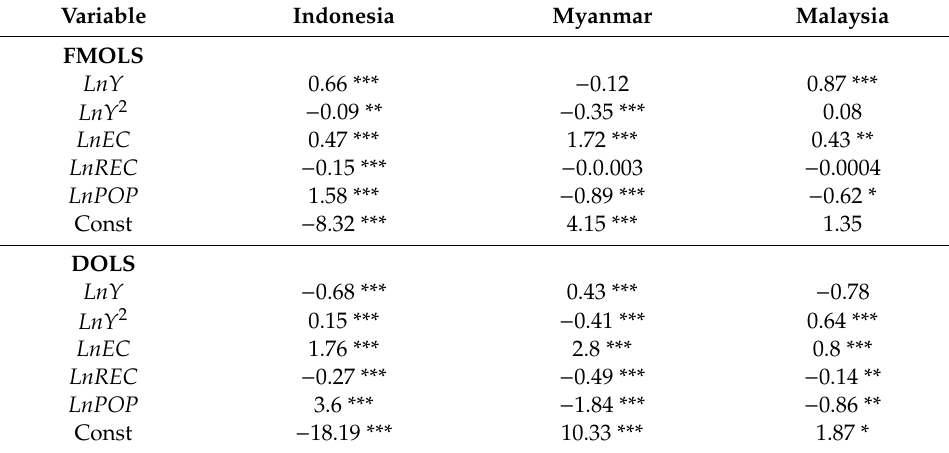
Table 4. The results from long-run